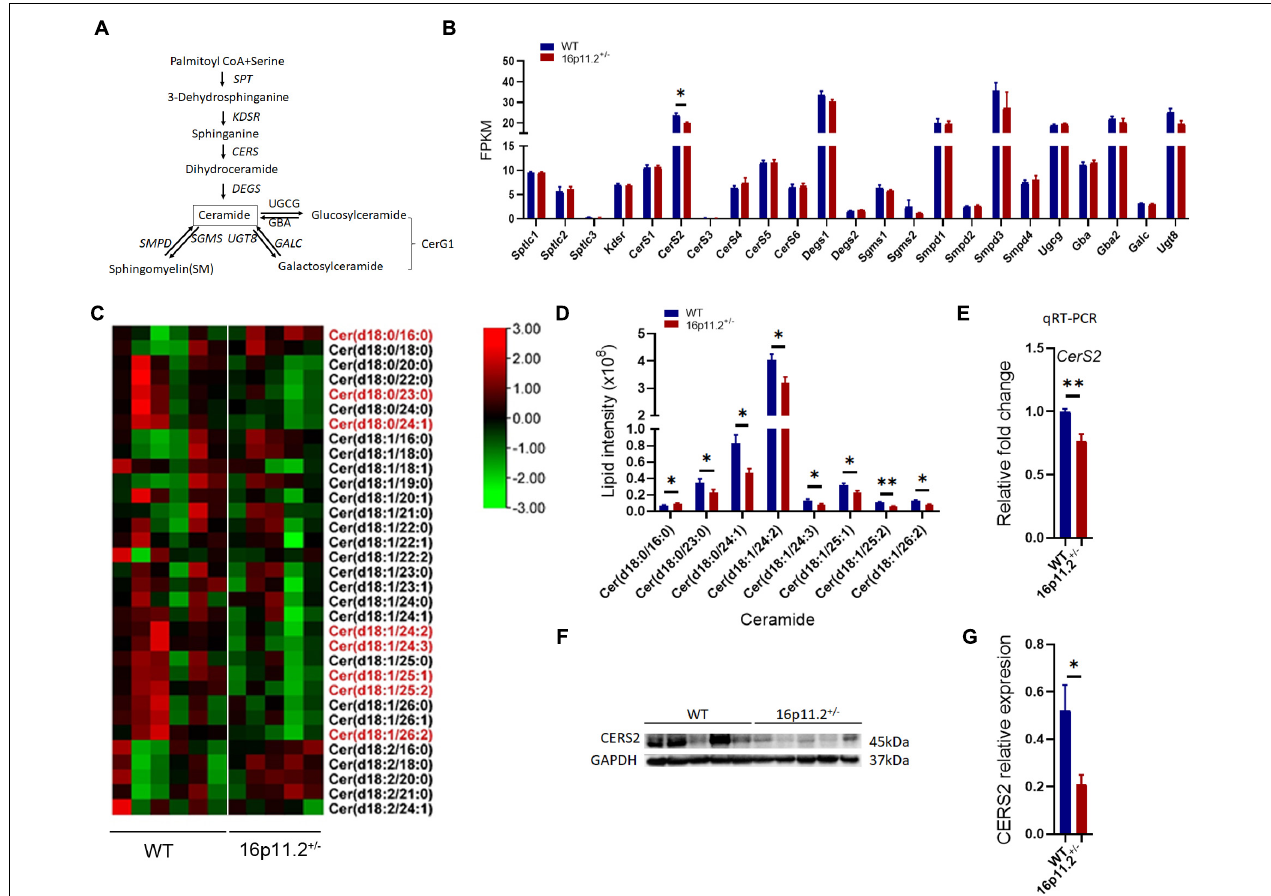
FIGURE 6 | Decreased Cer species and CerS2 expression in 16p11.2 ± striatum. (A) Diagram of ceramide metabolism. (B) Expression levels of genes involved in ceramide synthesis revealed by RNAseq analysis using RNA isolated from striatum tissues of P60 16p11.2 ± mice ( n = 4) and WT controls ( n = 4). Only CerS2 expression was significantly reduced in 16p11.2 ± striatum. (C) Heatmaps of Cer species identified by lipidomics analysis in the striatum of P60 16p11.2 ± mice ( n = 5) and WT controls ( n = 6). The Cer species displaying a significant change in level in 16p11.2 ± striatum are written in red. (D) Chart of comparing the “red” Cer species, indicating their decreased levels in the striatum of 16p11.2 ± mice in relation to WT controls. (E) Reduced CerS2 expression (relative to Gapdh ) in 16p11.2 ± striatum as assessed by qRT-PCR ( n = 4 mice). (F,G) Reduced CERS2 expression in 16p11.2 ± striatum revealed by Western blotting ( n = 5 mice). CERS2 expression was examined by Western blotting (F) and normalized against GAPDH for quantitative comparison (G) . Data were analyzed with unpaired t tests (mean ± SEM, * p < 0.05, ** p < 0.01). FPKM, Fragments per kilobase of transcript per million mapped reads.